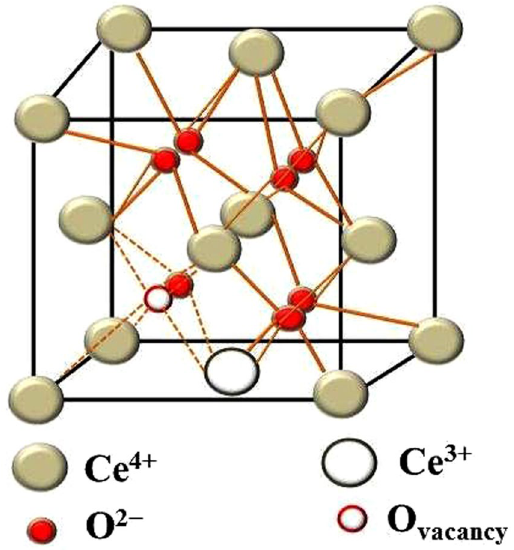
Figure 7. Schematic model of the CeO 2 structure showing Ce 3 + -ions and oxygen vacancy. The whitish color ball is Ce 4 + ; the red color ball is O 2 − on the lattice site; the red color circled ball is oxygen vacancy; the unfilled white ball represents Ce 3 + on the lattice site formed after removing oxygen either from surface or from the interior of CeO 2